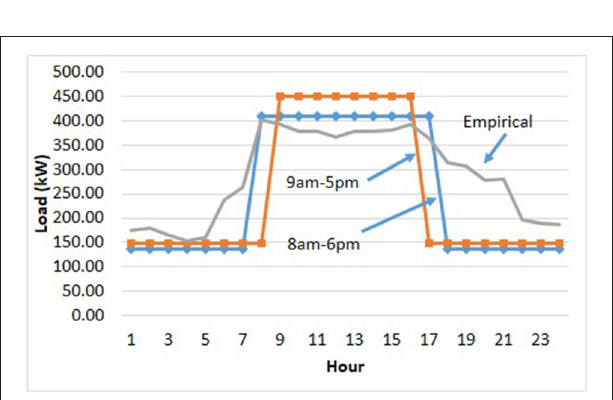
CA, over 24h and 12 months.